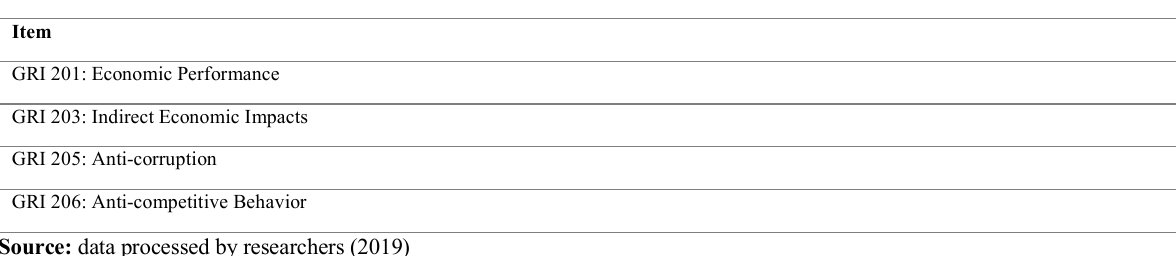
Table 3. Economic Item for Faculty SR